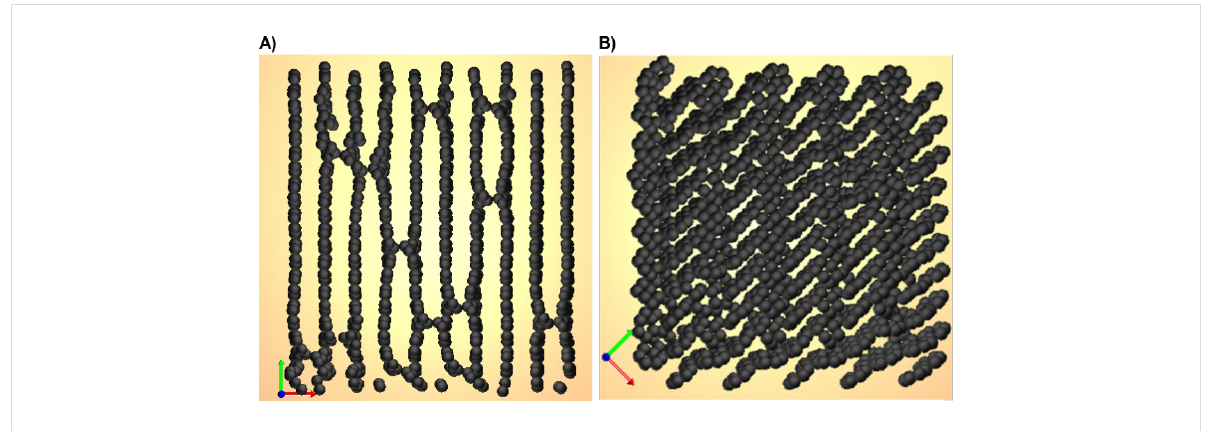
Figure 5: Examples of final structures for an initial triangular lattice geometry (A) and an initial herringbone geometry (B).